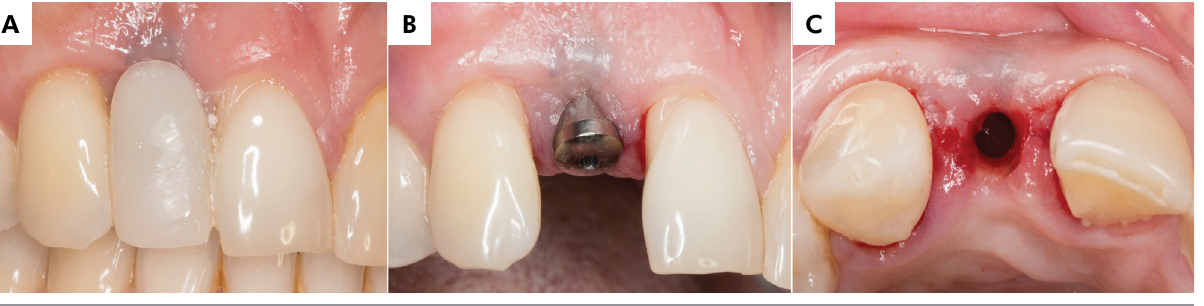
Figure 8. Patient complained due to loss of papillae at the implant site (a). The implant with a Morse taper connection was already placed in the proper mesio-distal positioning (b), so the healing abutment was removed to perform a CTG and improve the tissue contour and height